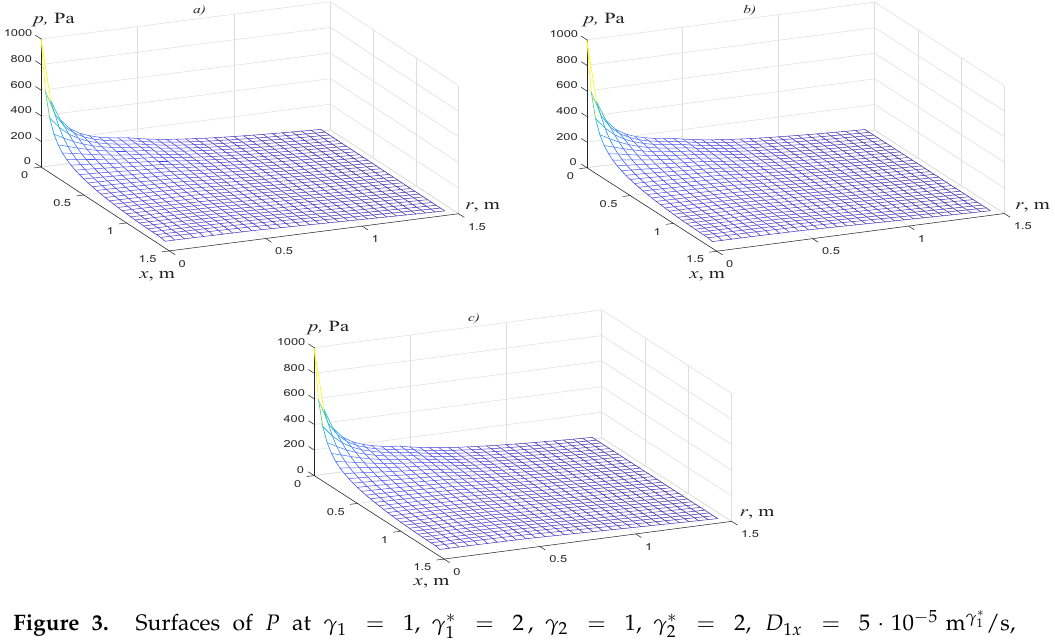
= 2, γ = 1, γ ∗ = 2, D = 5 · 10 − 5 m γ ∗ 1 /s, 2 1 x 2 1